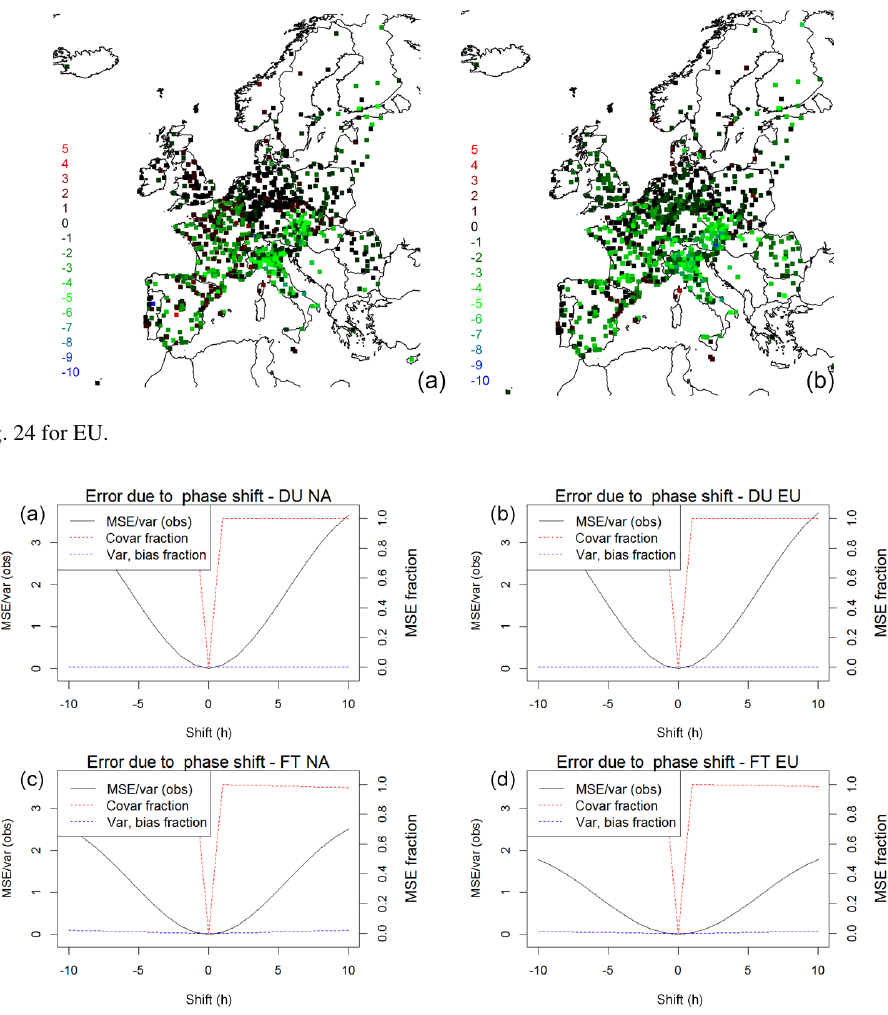
Figure 26. Normalised MSE produced by lagging the observed diurnal cycle with respect to itself. The MSE due to such a shift is entirely due to covariance error. The plots are presented for EU2 (b, d) and NA2 (a, c) for the months of JJA. Panels (a, b) shows the impact of the phase shift on the DU component, and (c, d) show results for the undecomposed time series (FT). For EU2, a shift of ± 3h causes an MSE of ∼ 0.5 times the variance of the